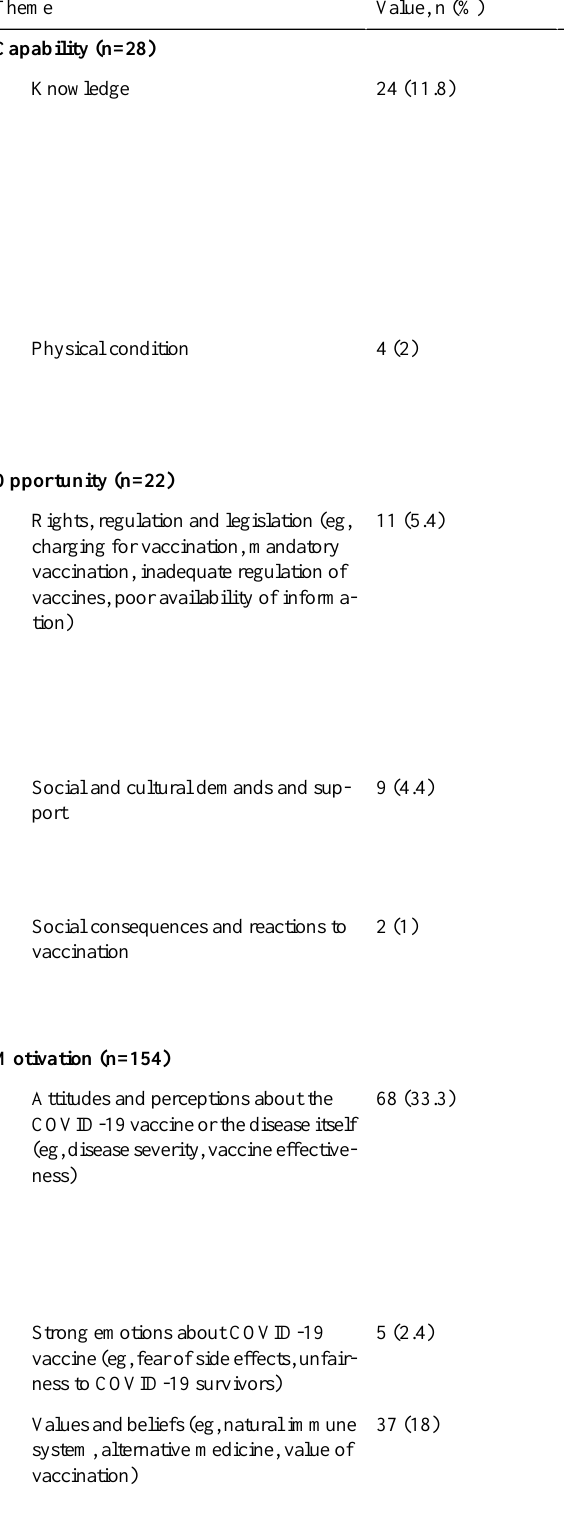
Example tweetsValue, n